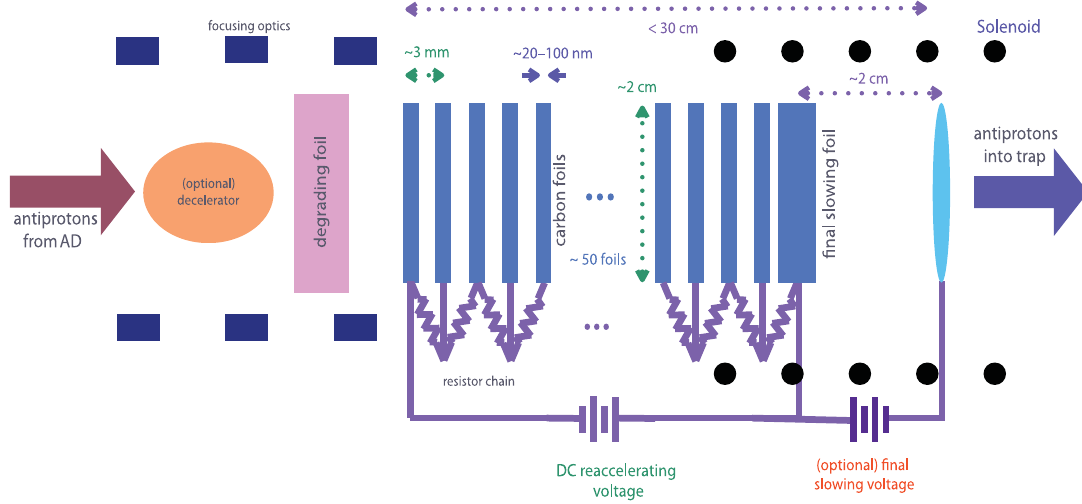
FIG. 1. Schematic of the proposed frictional cooling system. The diagram is not drawn to scale, but is intended to illustrate the major components. Cases with and without an additional active deceleration stage between the AD and the degrading foil are considered. Because the antiproton current is small and therefore the power requirements modest, presumably a resistor chain could be used to divide a single high voltage source. Final slowing might be achieved either by an oppositely polarized DC voltage or, as considered here, a thicker final